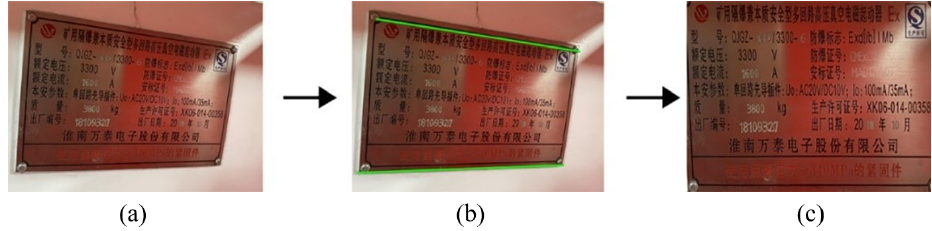
Figure 4. ( a ) Picture to be processed. ( b ) Locate the image position to be transformed by detecting the two longest edges of the industrial image. ( c ) All the text information features are enlarged as the final result of projection